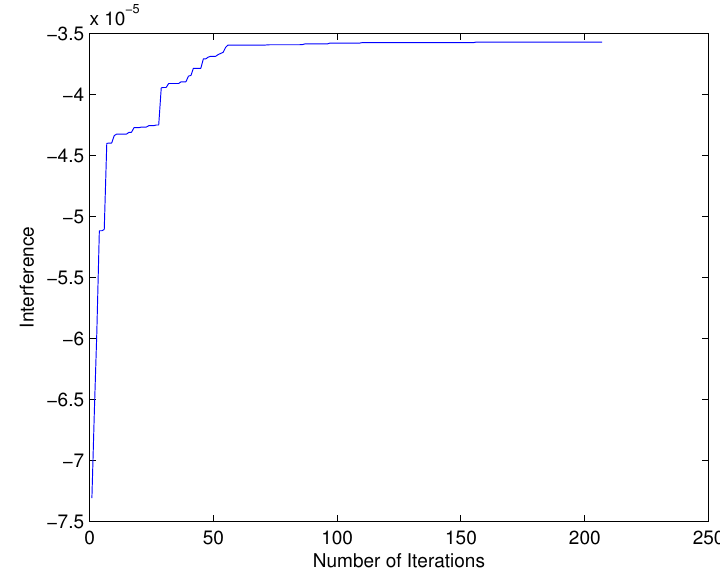
Figure 4. Total Interference